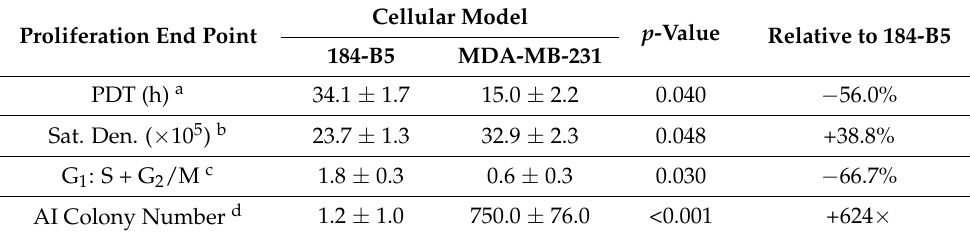
Table 1. Hyper-proliferation in the TNBC model.